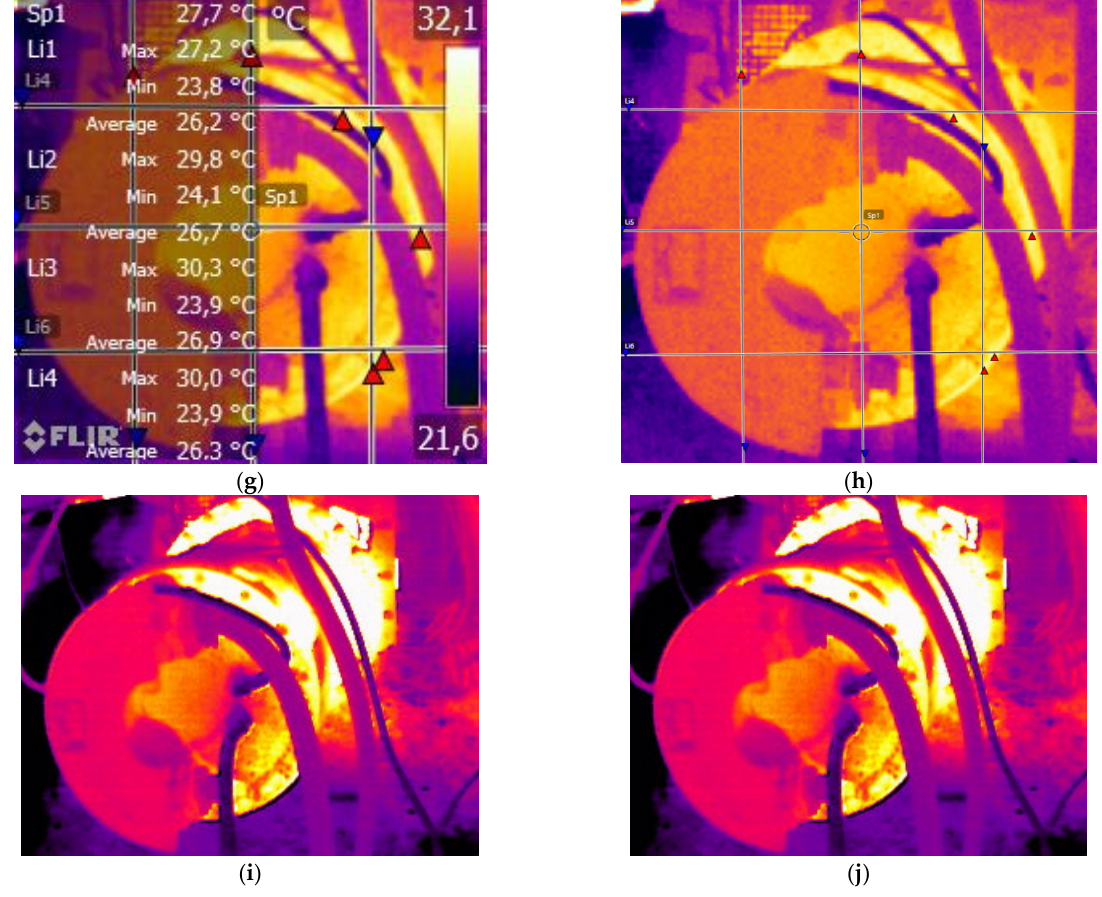
Figure 6. A view from a measurement session made with a thermal imaging camera together with processing in the software FLIR Tools for (II) drive unit of belt conveyor PT-4 from the analysed main haulage, where heat distribution is presented for: ( a ) photo of the tested right gearbox (II); ( b ) thermogram with visible thermal effect for the right gearbox (II); ( c , d ) thermogram showing the heat distribution for the right gearbox (II); ( e ) photo of the tested right engine (II), ( f ) thermogram with visible thermal effect for the right engine (II); ( g , h ) thermogram showing the heat distribution for the right engine (II); ( i , j ) thermogram showing the heat distribution taken with the Dräger UFC 9000 camera.